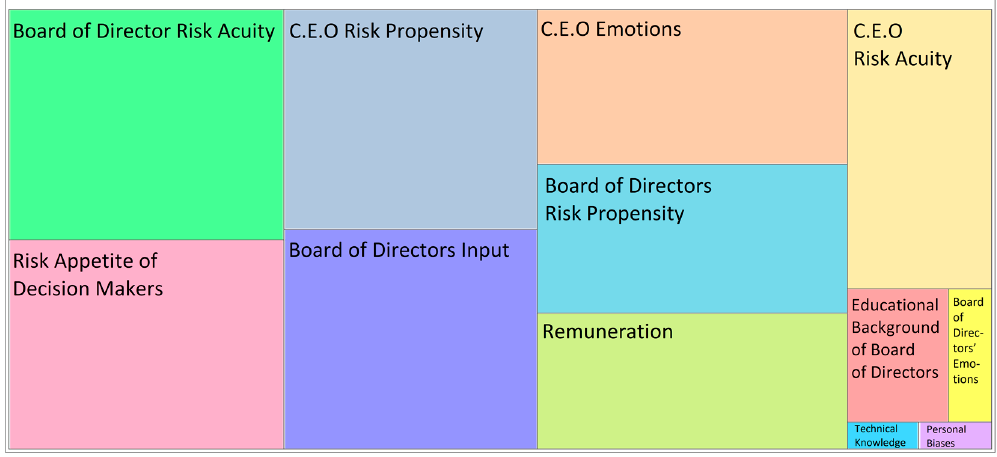
Figure 9. Hierarchy chart of decision maker factors.